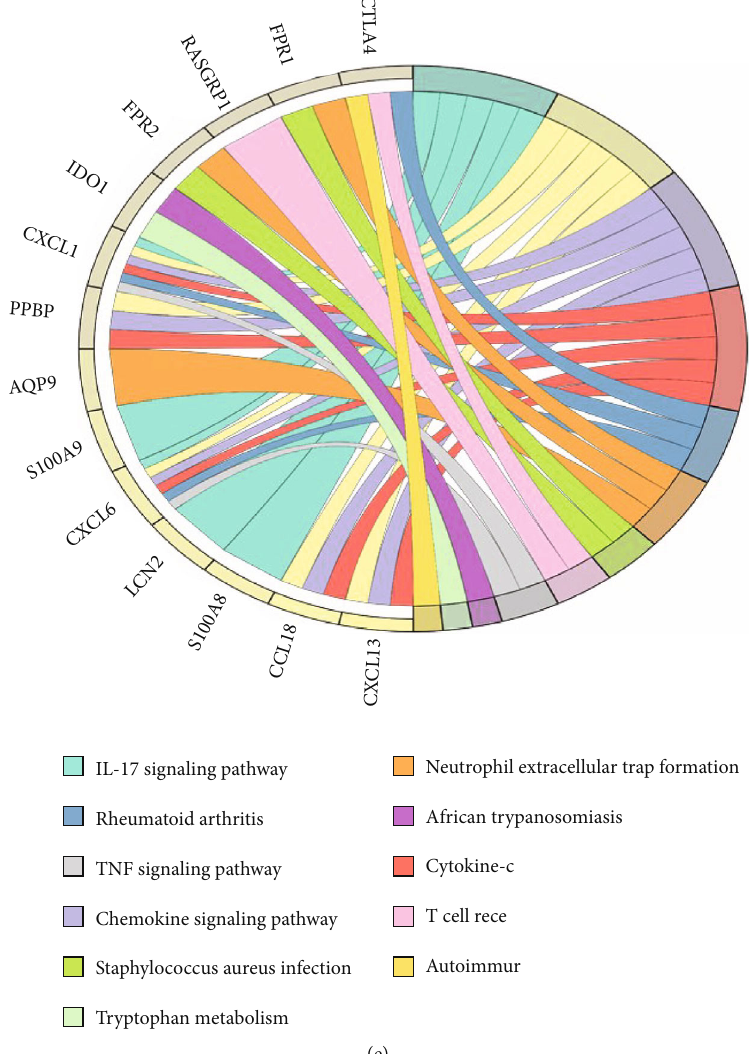
Figure 2: Construction of protein-protein interaction network and identi fi cation of hub immune-related IC-DEGs. (a) Protein-protein interaction network of 24 immune-related IC-DEGs. (b) Left: identi fi cation and visualization of 19 hub based on the Molecular Complex Detection (MCODE) tools in Cytoscape. Right: MCODE analysis showed the most active modules. (c) The bar plot shows the degree value of the 19 hub genes. (d) GO enrichment analysis based of the 19 hub genes. (e) KEGG enrichment analysis based of the 19 hub